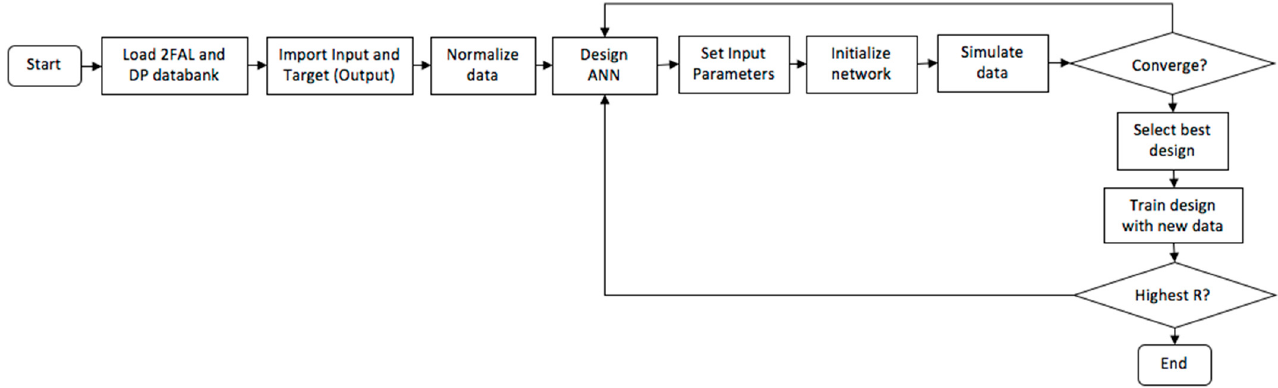
Figure 5. Proposed ANN flowchart.